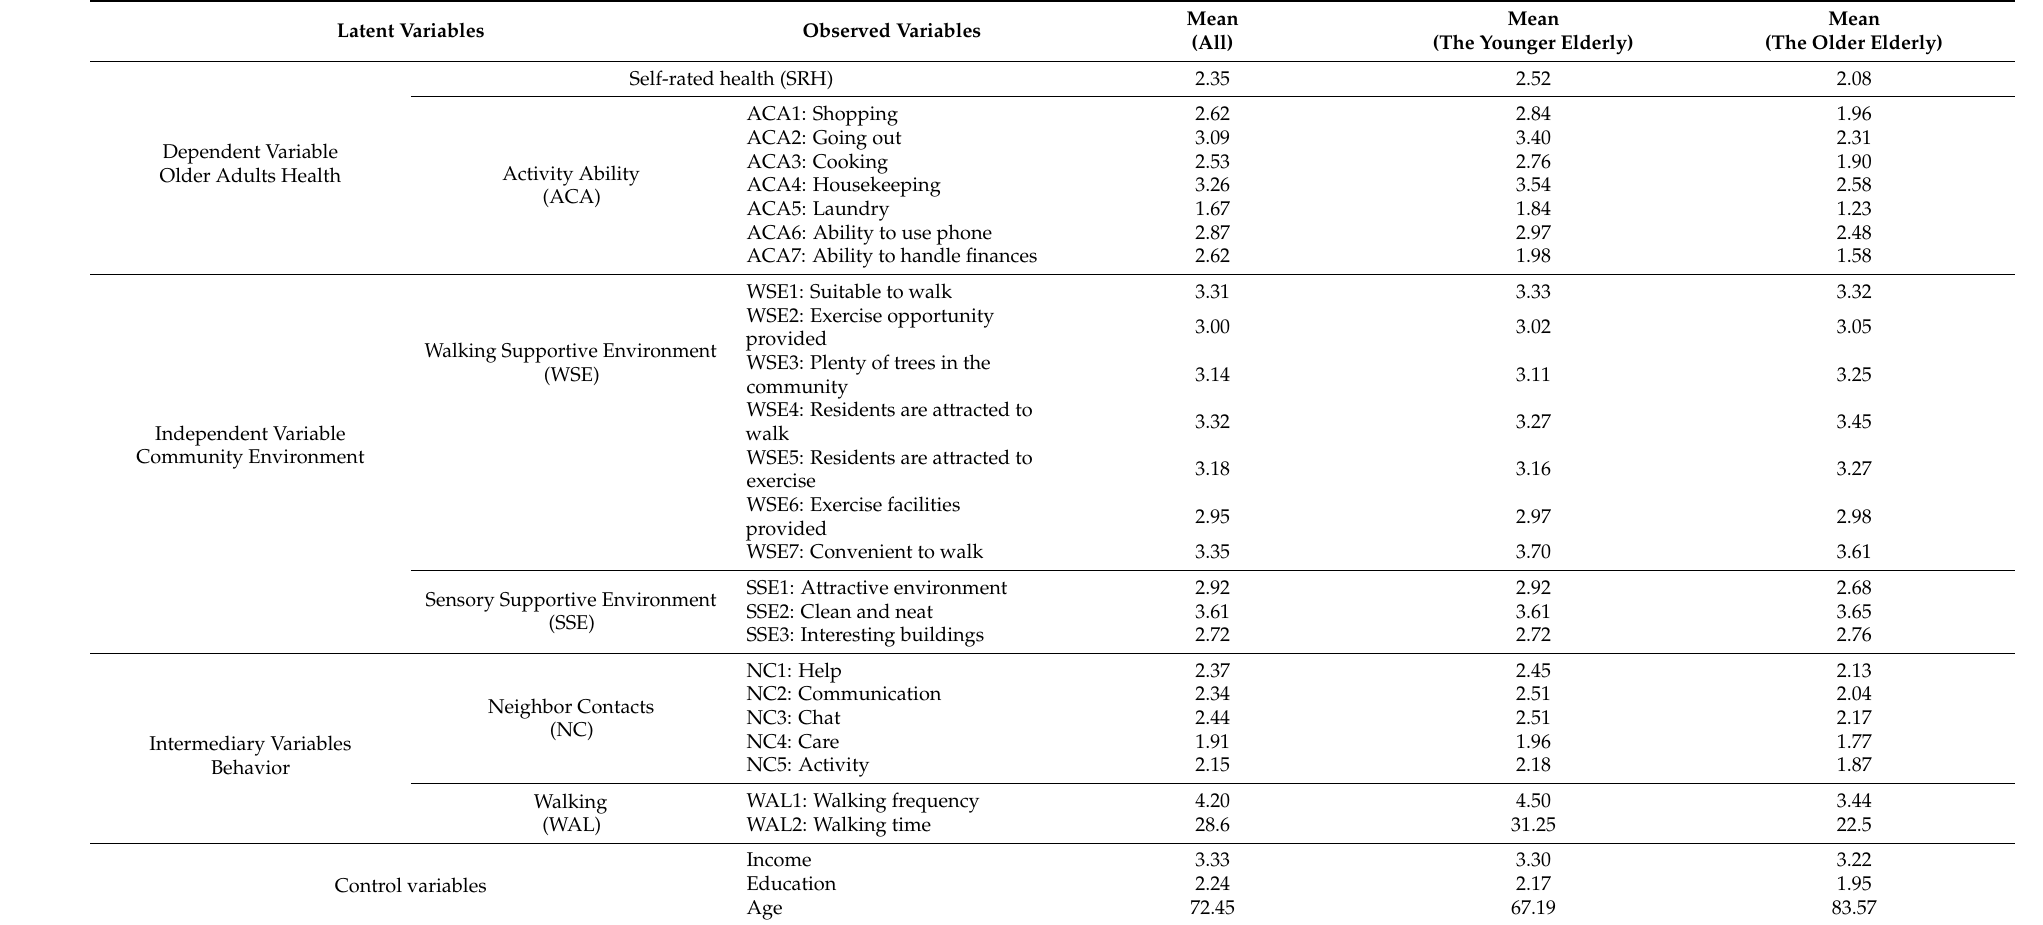
Table 1. Characteristics of